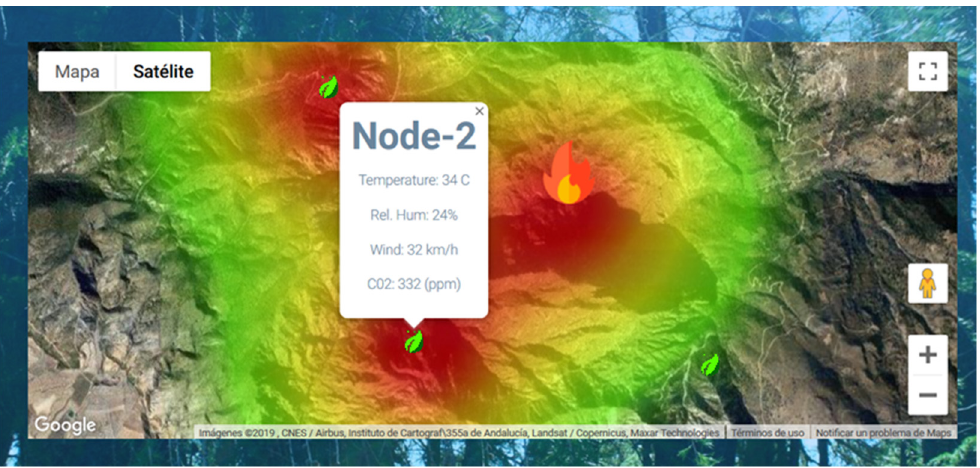
Figure 15. Website showing 4 nodes and the measured data.